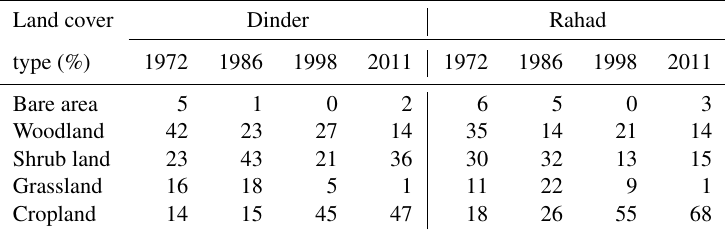
Table 4. Land cover changes (%) in Dinder and Rahad basins that occurred in the periods 1972–1986, 1986–1998 and 1998–2011. Land cover Dinder